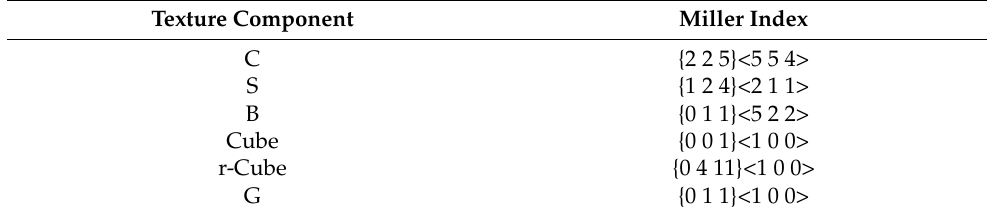
Table 3. Texture components and corresponding Miller indices in